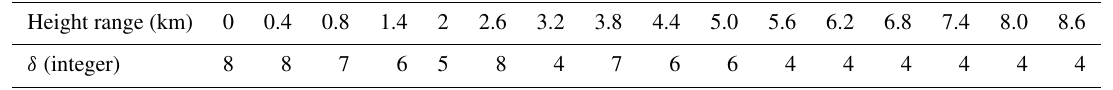
Table 3. Smoothing factor derived by ERA-Interim products at different heights. Height range (km)